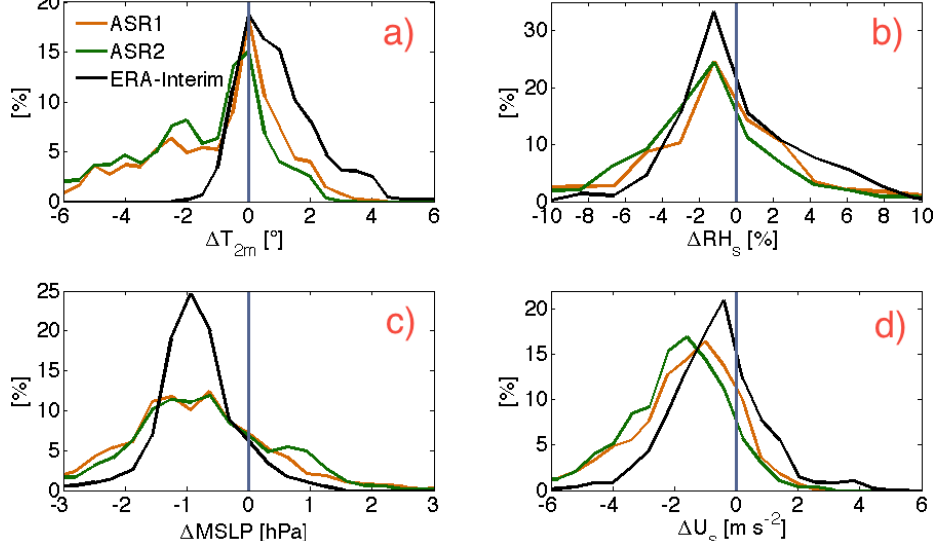
Fig. 5. Histograms (%) of the difference between each reanalysis and the ASCOS observations for the variables in Fig. 4: (a) 2m temperature in ◦ C, (b) relative humidity (RH) in %, (c) surface pressure in hPa, and (d) scalar wind speed in ms − 1 .